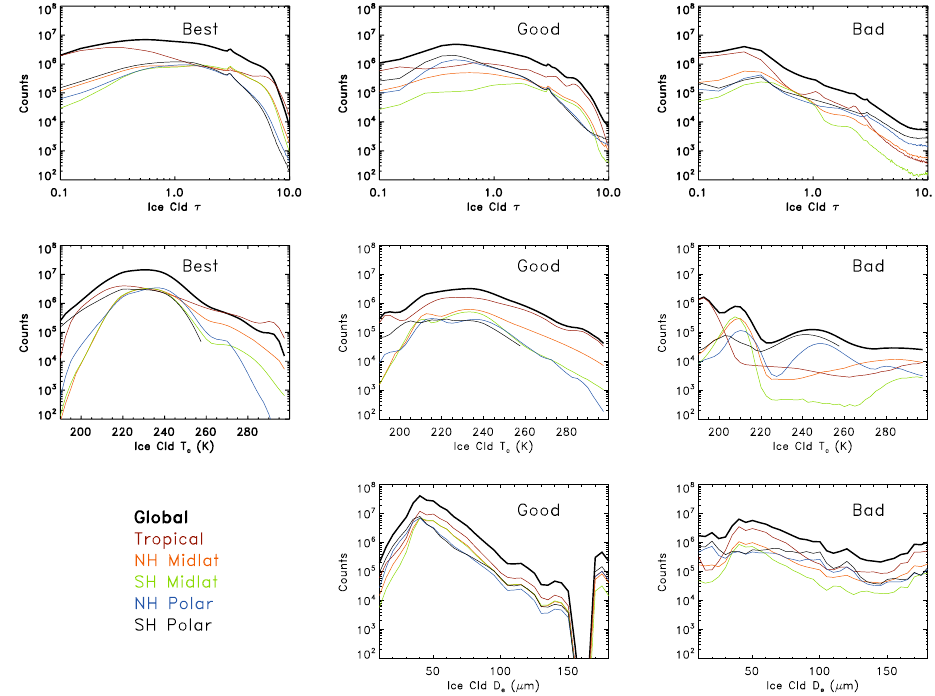
Fig. 10. Histograms of τ (top row), T C , ICE (middle row), and D e (bottom row) for QC = 0 (“best”, left column), QC = 1 (“good”, middle column) and QC = 2 (“do not use”, right column) retrievals for 2007. The histograms are organized by latitude band: tropics (30 ◦ S–30 ◦ N), SH (60–30 ◦ S) and NH (30–60 ◦ N) midlatitudes, and SH (90–60 ◦ S) and NH (60–90 ◦ N) polar